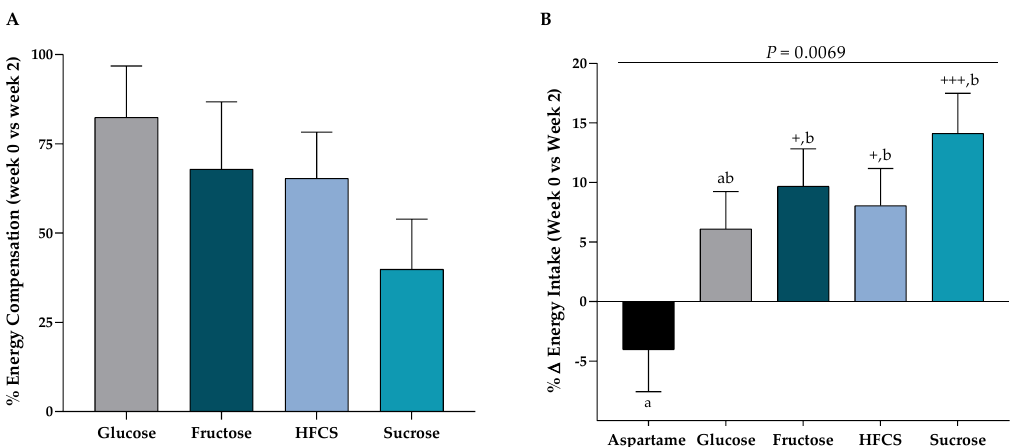
Figure 3. Energy compensation and intake during ad libitum food intake trials: Subjects consumed 3 ad libitum buffet meals at Week 0 and consumed identical meals with glucose-, fructose-, high fructose corn syrup (HFCS)-, sucrose-, or aspartame-sweetened beverages at Week 2. ( A ) Mean ± SEM of the percent energy compensation for sugar-SB at Week 2 compared with Week 0 with < 100% denoting partial compensation. ( B ) Mean ± SEM of the % change in energy intake at Week 2 compared with Week 0. p = 0.0069 effect of SB, 2-factor (SB group, sex) analysis of covariance with adjustment for BMI; + p < 0.05, +++ p < 0.001, LS mean different from zero; a different from b, Tukey’s. Table 3. Change in energy and macronutrient intake (Week 2–Week 0) during ad libitum food intake trials 1